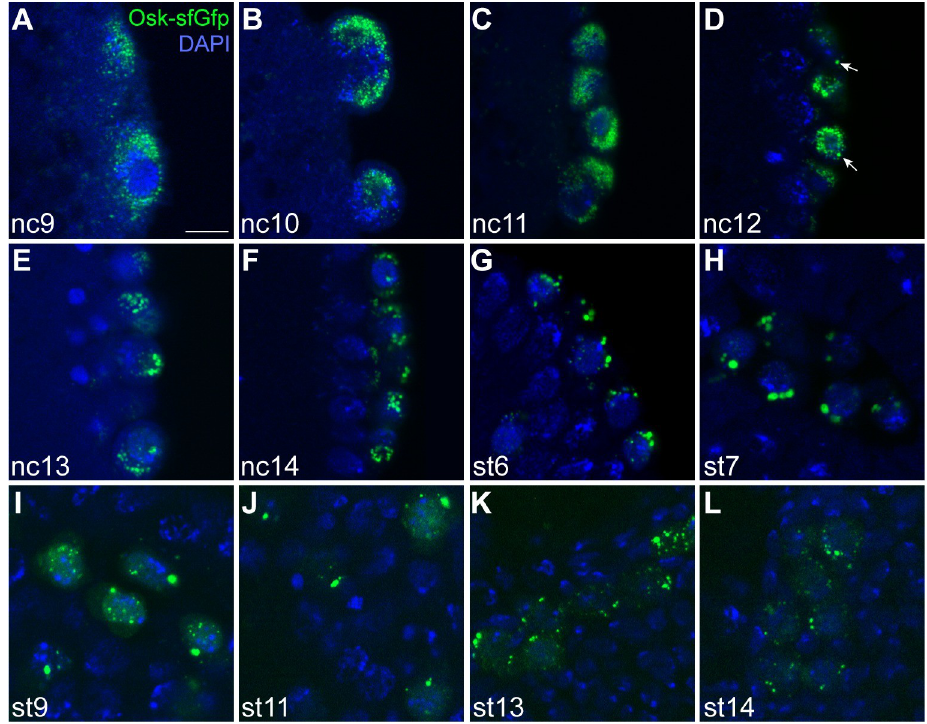
Fig 1. Germ granules increase in size and persist through gonad formation. Single confocal sections, showing endogenously tagged Osk-sfGFP (green) in the pole cells after pole cell budding (A–F), throughout gastrulation (G–H) and during pole cell migration (I–L). Embryos were staged by nuclear cycle (nc, A–F) or Bownes stage (st, G–L) according to nuclear density or morphological features, respectively. Osk-sfGFP was detected by anti-GFP immunofluorescence and nuclei were stained with DAPI (blue). The brightness and contrast were adjusted individually for each image to best show the features of the germ granules at that stage. Arrows indicate examples of the larger germ granules that first appear at nc12. Scale bar: 5 μ